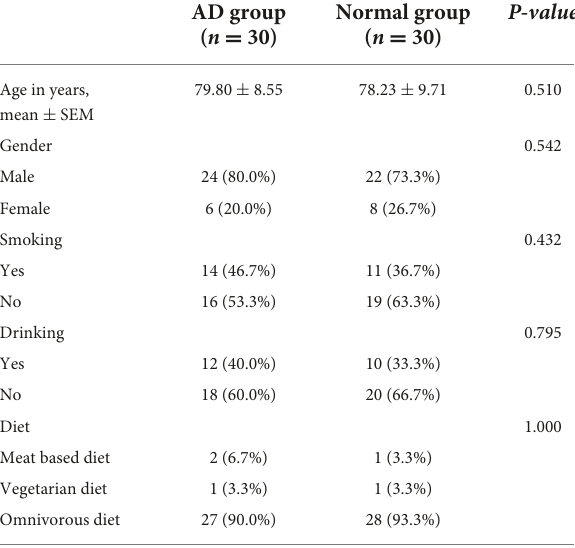
TABLE 1 Basic characteristics of the subjects in each group.